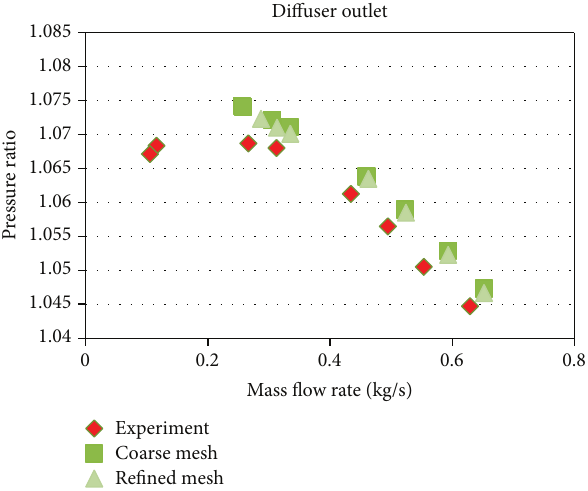
Figure 14: Pressure characteristic at the diffuser outlet for the sta- tionary case in the diffuser outlet.